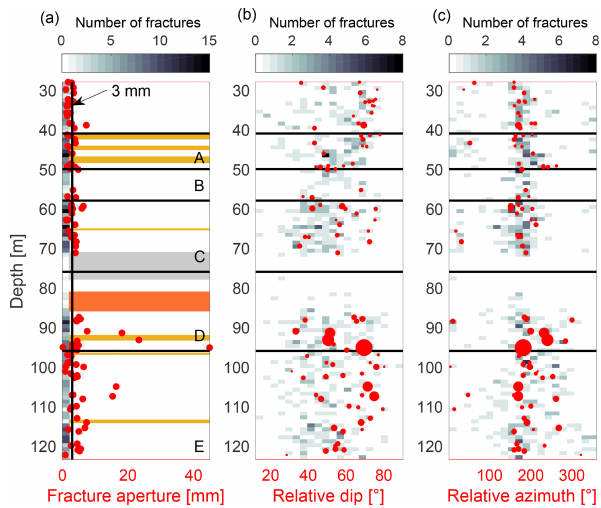
Figure 5. Summary of the brittle deformation based on the OTV data (Egli et al., 2018) (a) fracture aperture, (b) relative dip, and (c) relative azimuth. All identified fractures are displayed in histo- graphic form along the borehole. Fractures with measurable aper- ture (greater than 0.8mm) are displayed as red dots. In (a) addition- ally cataclastic zones, the cementation zone, and main fault core are